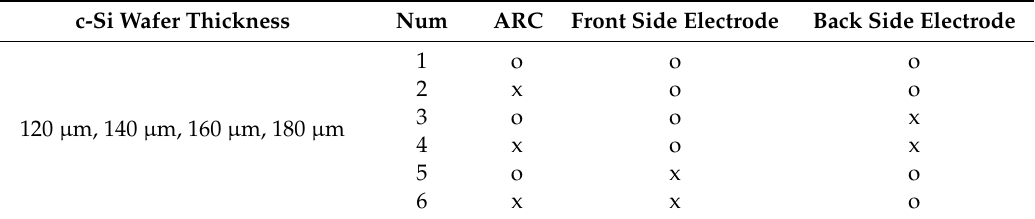
Table 1. Design of experiments (DOE) of partially processed solar cells according to the thickness of the c-Si wafer. ARC: anti-reflection coating.